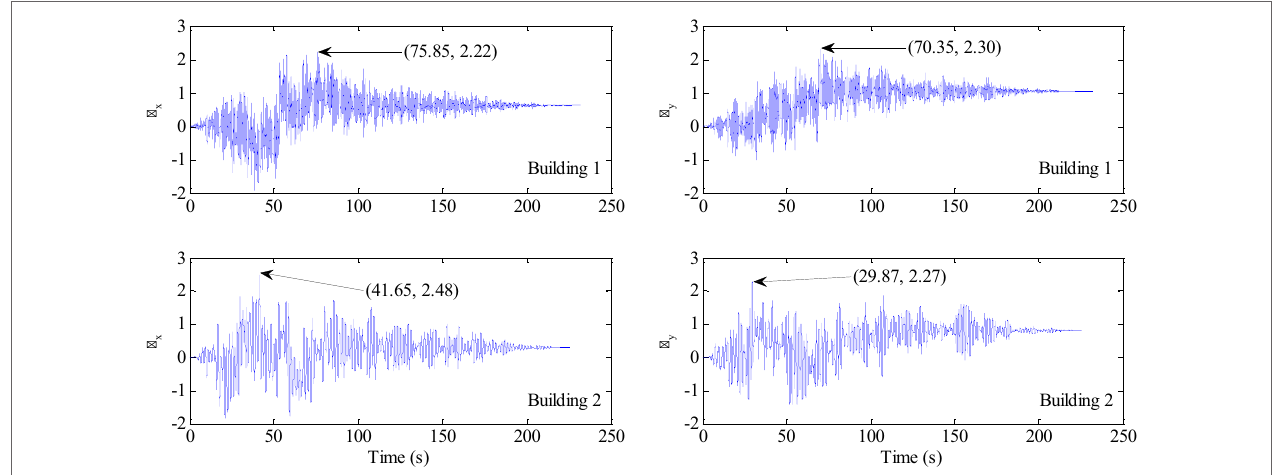
FIGURE 7 | Non-linear inelastic response of the buildings modeled as single-degree-of-freedom systems, in terms of normalized displacement response μ x and μ y , under the unidirectional ground motions shown in Figure 4 . The peak normalized displacement and its corresponding time is also shown.